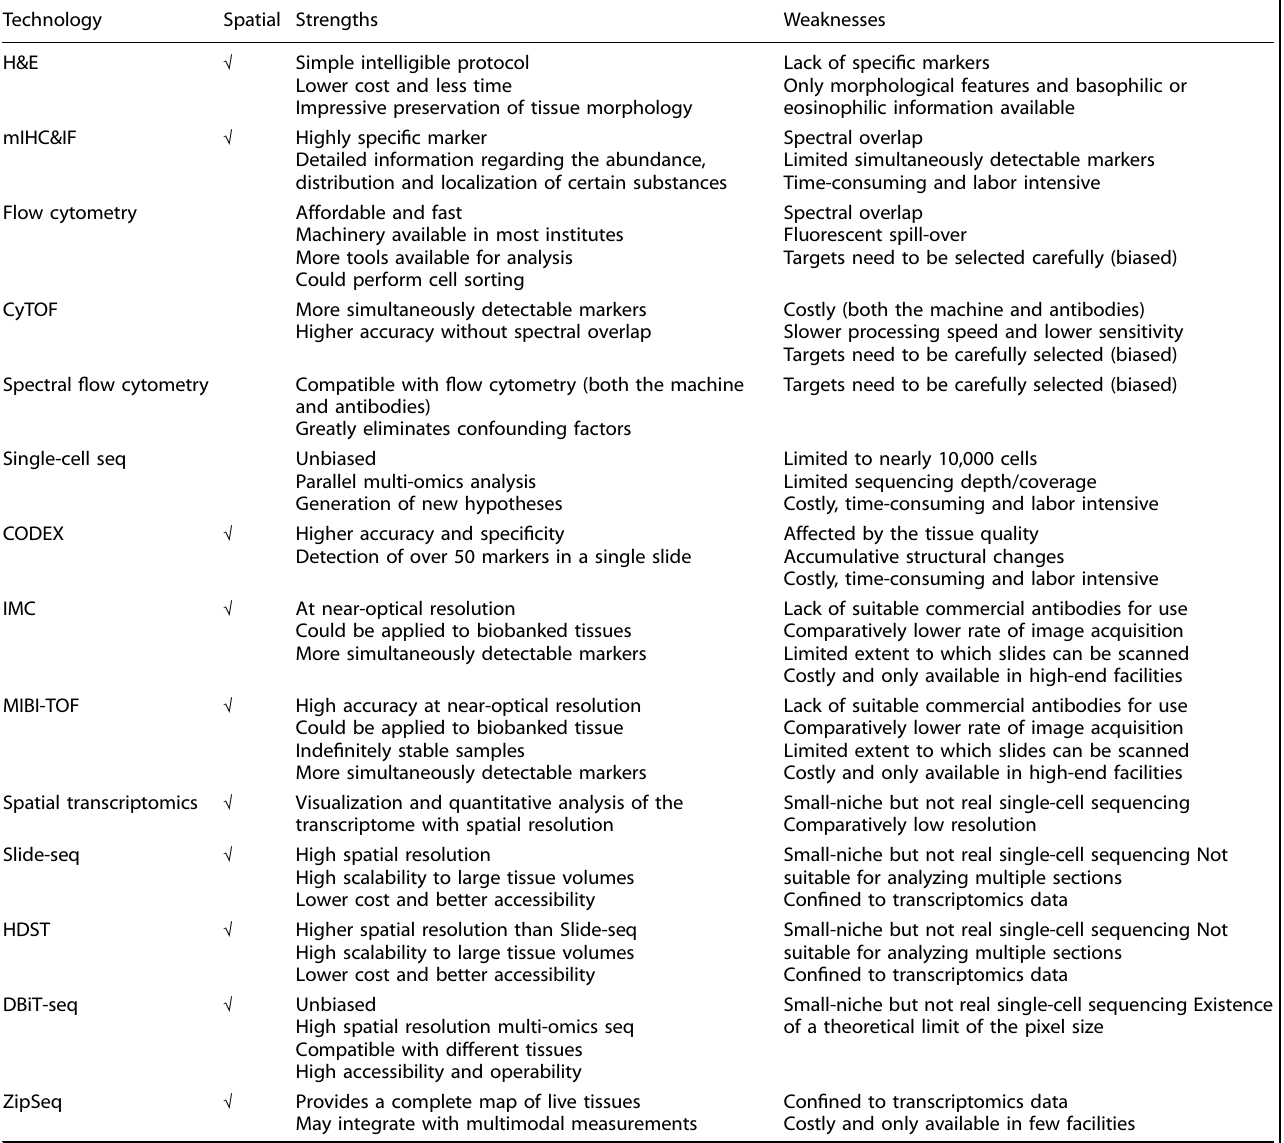
Table 3. Comparison of immunomics technologies at the single-cell level